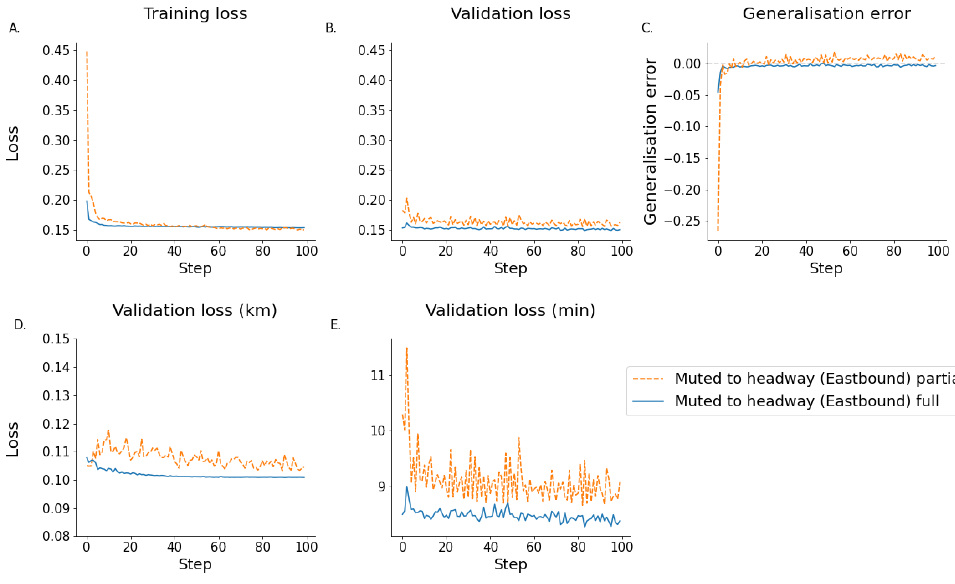
Figure 15. Comparison of the westbound headway muted model trained on a partial as well as a full dataset. ( A ) shows the training loss. ( B ) shows the validation loss. ( C ) shows the generalisation error calculated by subtracting the training error from the testing error. ( D ) shows the estimated validation error in km. ( E ) shows the estimated validation loss in minutes. (Note that subfigure ( D ) has a truncated y axis for illustration purposes).